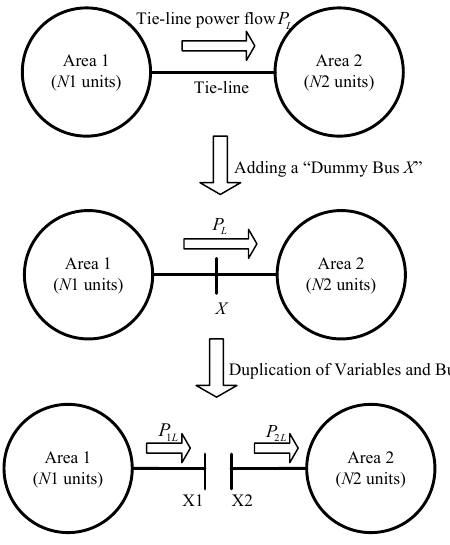
Figure 1. Decentralization of an interconnected power